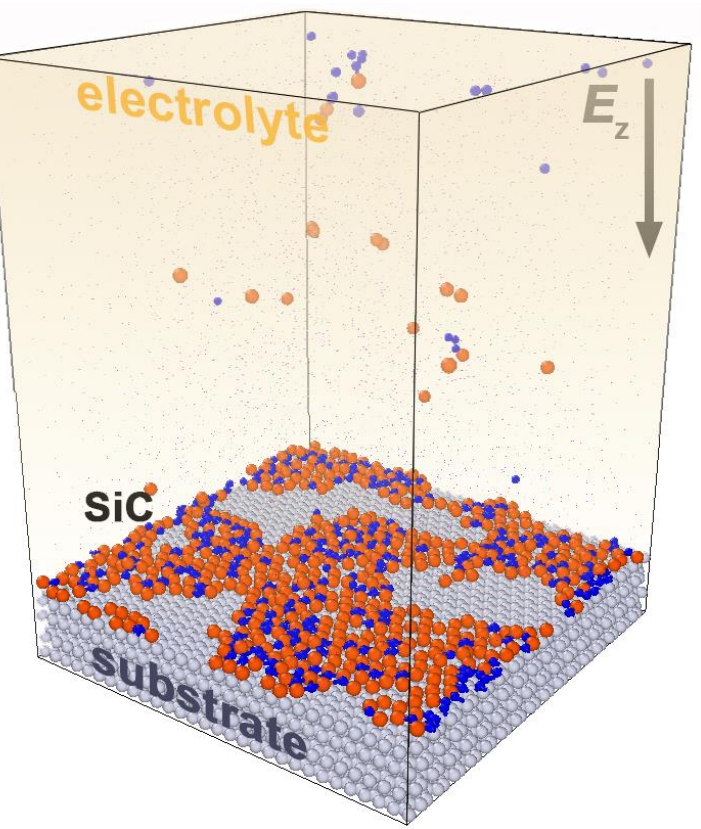
Figure 1. Process of Si 4+ and C 4+ ions deposition from the melt onto the substrate; the ions were introduced periodically, and moved under the action of an external field E z .